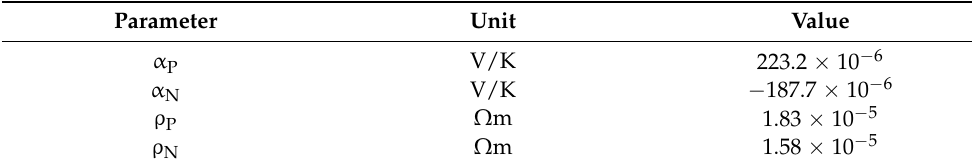
Figure 1. SPTEG configuration and electric circuit. ( a ) Top view of the SPTEG. ( b ) Side view of the SPTEG. ( c ) Schematic of the electric circuit for the present SPTEG with forty TE modules. Table 2. TE properties of SAGREON